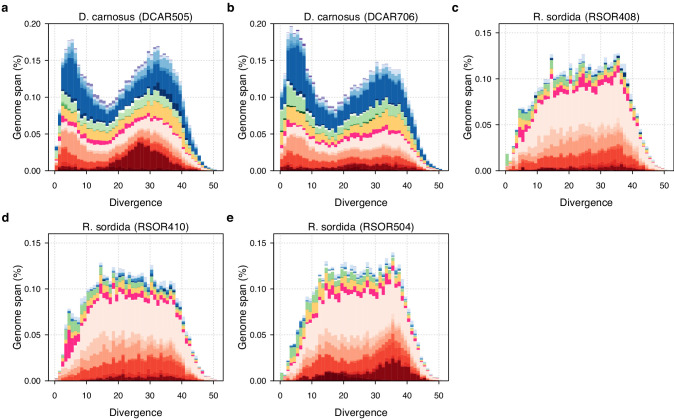
TE divergence landscapes for individual D. carnosus and R. sordida genomes.